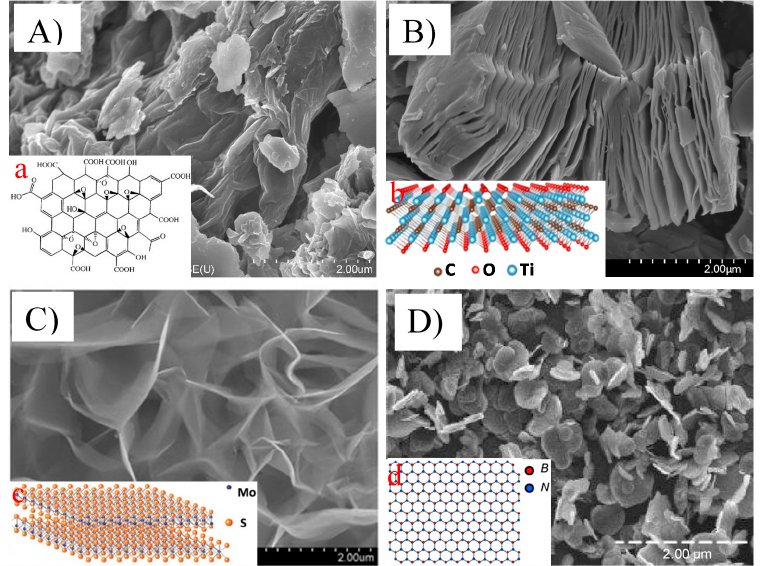
Figure 1. Scanning electron microscopic images showing the morphology of (( A ) and ( a )) graphene oxide nanosheets (reproduced from [23,24] with permission from the Royal Society of Chemistry and Dove Medical Press Limited, respectively), (( B ) and ( b )) titanium carbide (Ti 3 C 2 ) MXene nanosheets (reproduced from [25,26] with permission from the Elsevier), (( C ) and ( c )) MoS 2 nanosheets (repro- duced from [22,27] with permission from the Royal Society of Chemistry and Elsevier, respectively), and (( D ) and ( d )) boron nitride nanosheets (reproduced from [27,28] with permission from the MDPI and Royal Society of Chemistry,